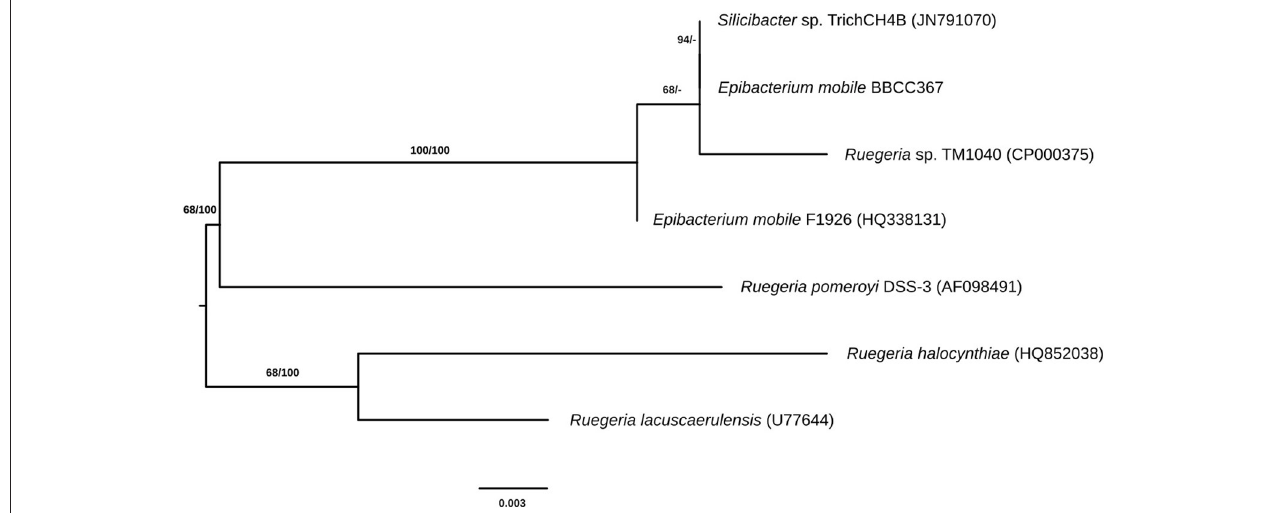
FIGURE 1 | Phylogenetic tree of closely related species to E. mobile (the identifiers in brackets are IDs from the ribosomal database of full-length 16S sequences).